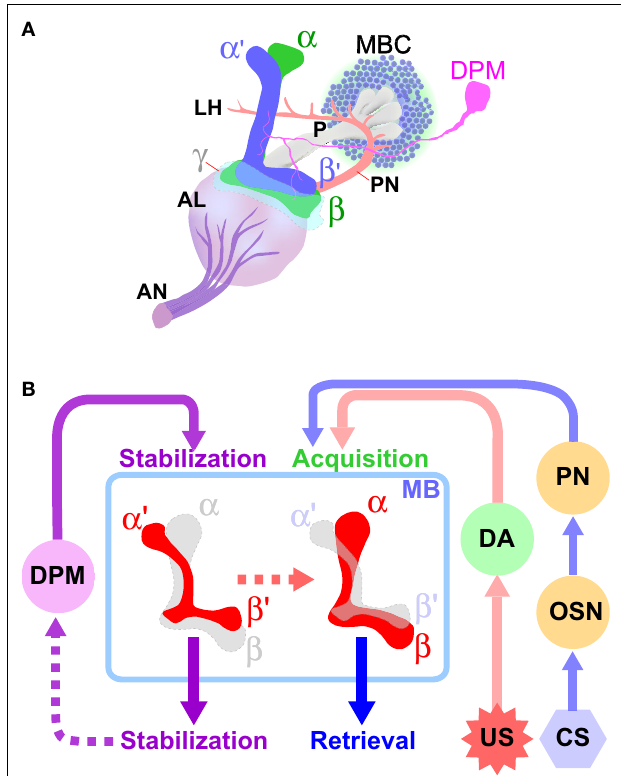
FIGURE 2 | Diverse roles of intrinsic and extrinsic mushroom body- associated neurons in the processing of aversive olfactory memory. (A) The mushroom body and associated neurons in one brain hemisphere are schematically represented (adapted from Armstrong et al., 1998). The cell bodies of Kenyon cells (MBCs), the mushroom body-intrinsic neurons, are located in the dorsal and posterior cortices of the brain. They extend axons anteriorly through a structure called the peduncle (P). The axons of α / β and α′ / β′ neurons bifurcate to form vertical ( α and α′ ) and horizontal ( β and β′ ) lobes. The axons of γ neurons do not bifurcate, and form only a horizontal lobe ( γ ). The primary olfactory information received by the olfactory neurons is transmitted through the antennal nerve (AN) to the fi rst olfactory center antennal lobe (AL), where the information is processed and further transmitted to the mushroom bodies by the projection neurons (PN). The dorsal paired medial (DPM) neuron extends an axon that branches and terminates in all lobes of the mushroom body. (B) Conditioned stimuli (CS; e. g. odors) and unconditioned aversive stimuli (US; e.g. electric shock) are simultaneously presented to fl ies. The olfactory information received by the olfactory neurons (OSN) is conveyed to the mushroom bodies (MB)